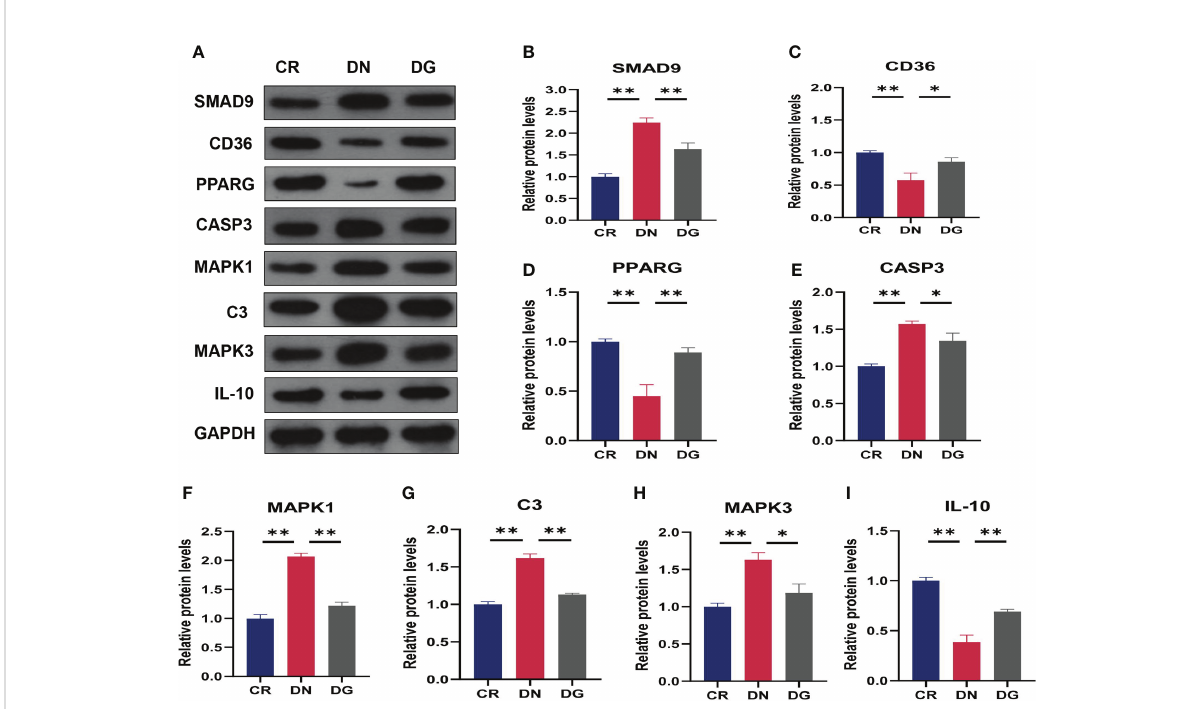
FIGURE 10 Validation of key targets by western blotting (n=3). (A) The protein expression of key targets was detected by western blotting. (B – I) Densitometry analysis of western blotting. Data are presented as the mean ± SE. *P < 0.05; **P < 0.001. CR, control group; DN, diabetic nephropathy group; DG, dapagli fl ozin